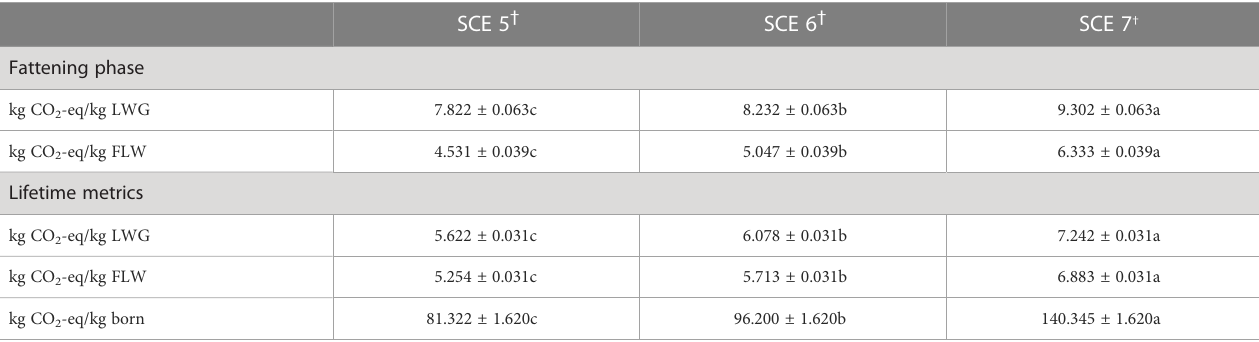
TABLE 4 Estimated carbon dioxide equivalent (CO 2 -eq) methane emission impact of commercial Brahman ( Bos indicus ) steers ’ grazing on Brachiaria decumbens pastures before slaughter with three contrasting scenarios